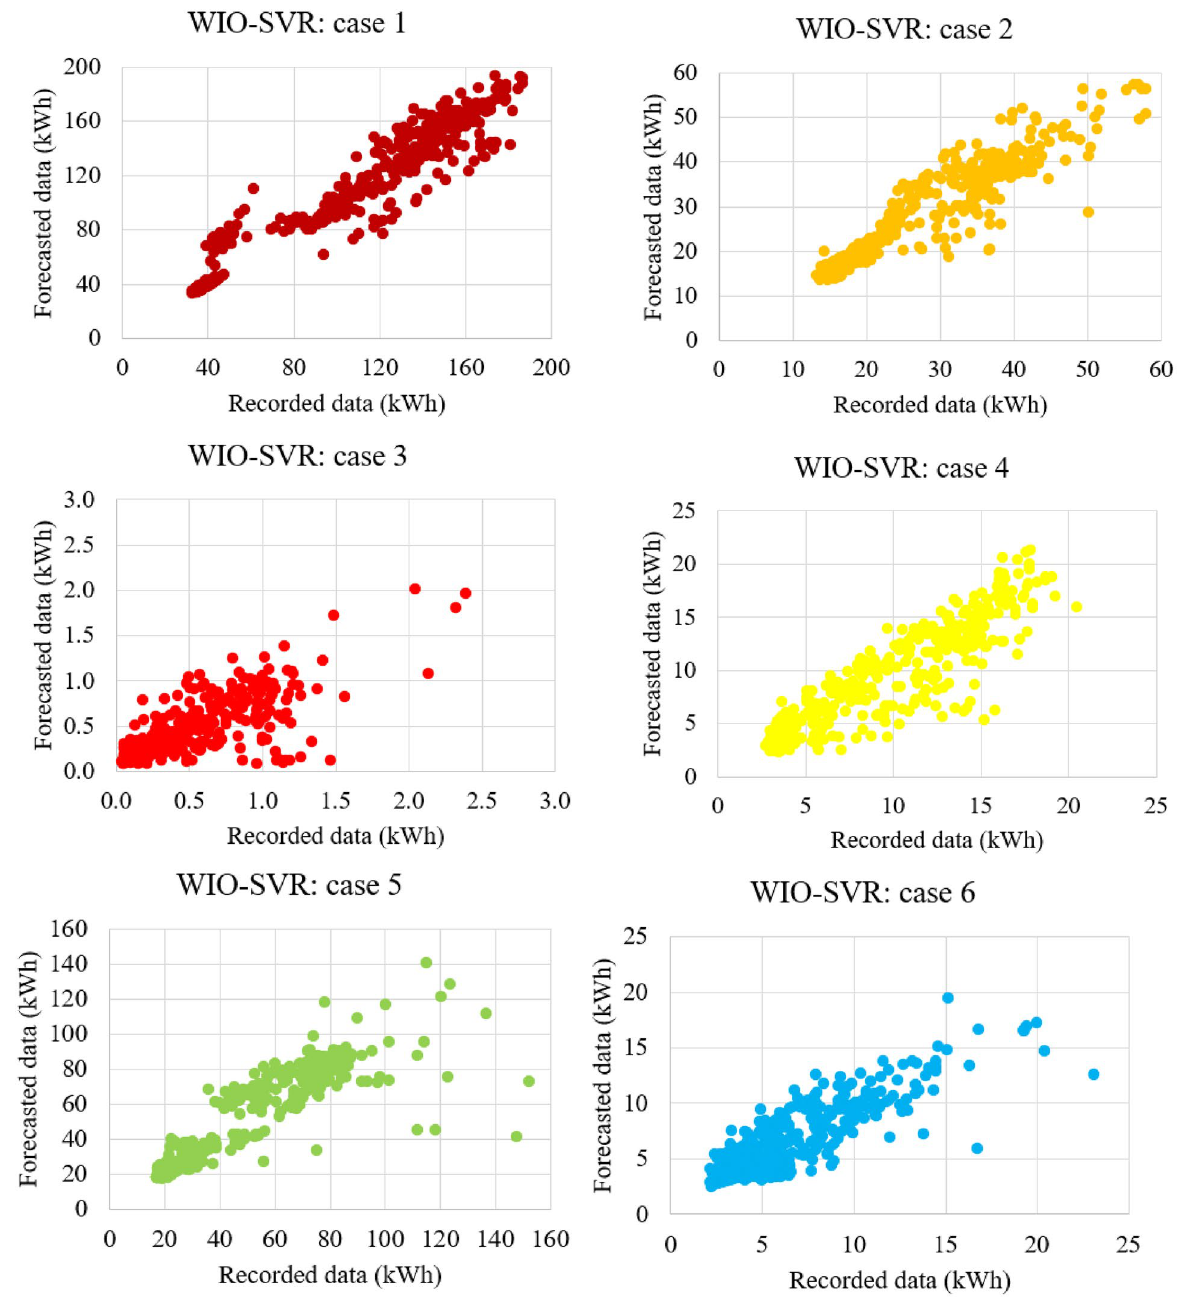
Figure 11. Scatter plots between recorded data and forecasted data by WIO-SVR in 12